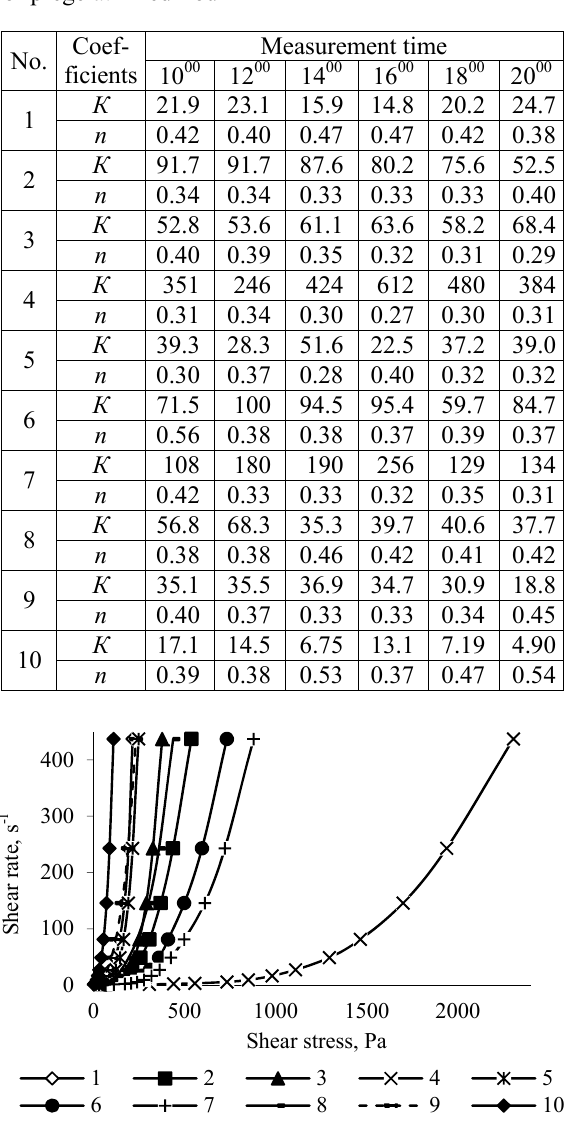
Table 3. Value of coefficients during the fermentation of pregelatinized flour